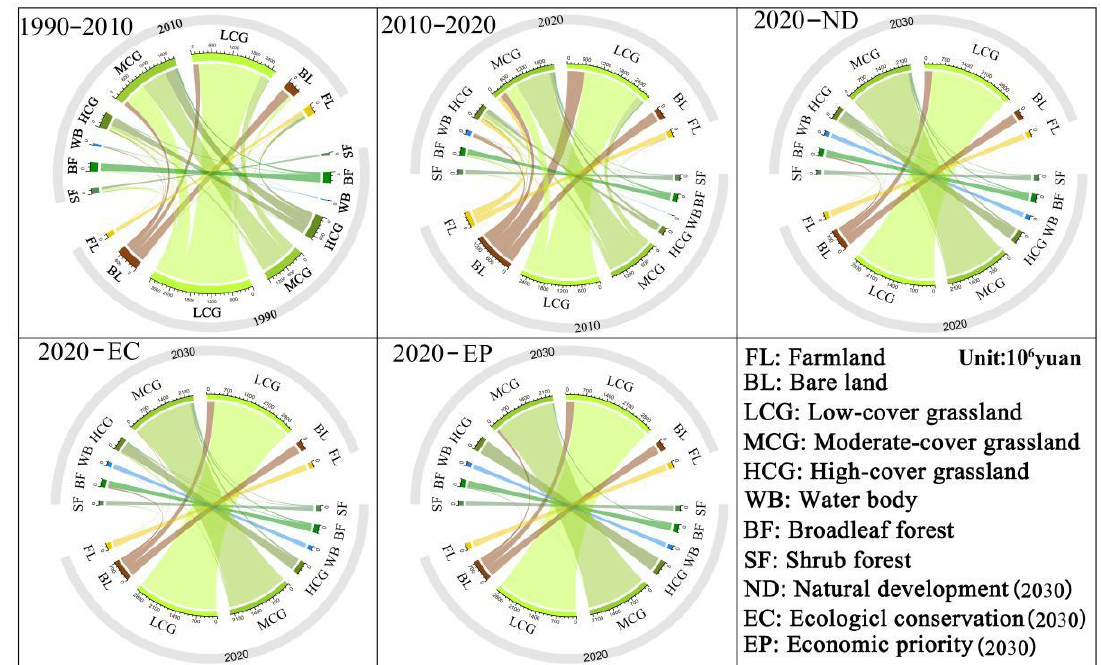
Figure 5. Ecosystem service value (ESV) changes caused by land use change from 1990 to 2030 under the different scenarios.